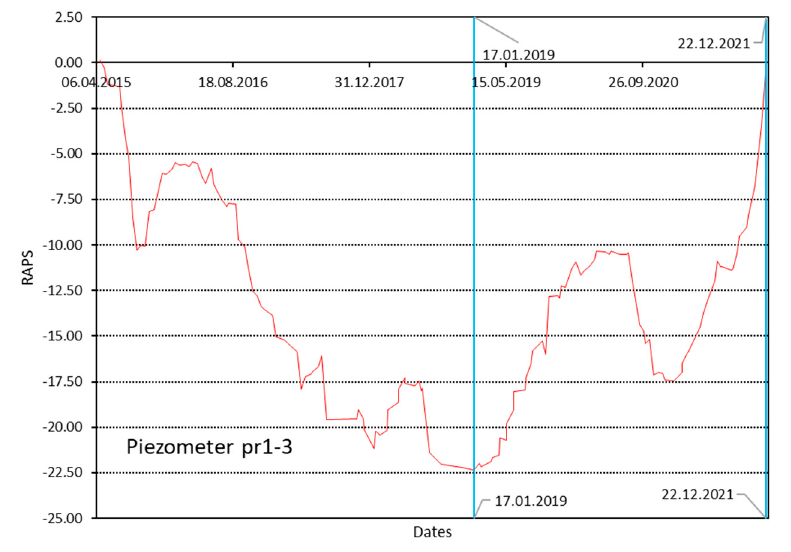
Figure 17. RAPS values for piezometer MR.